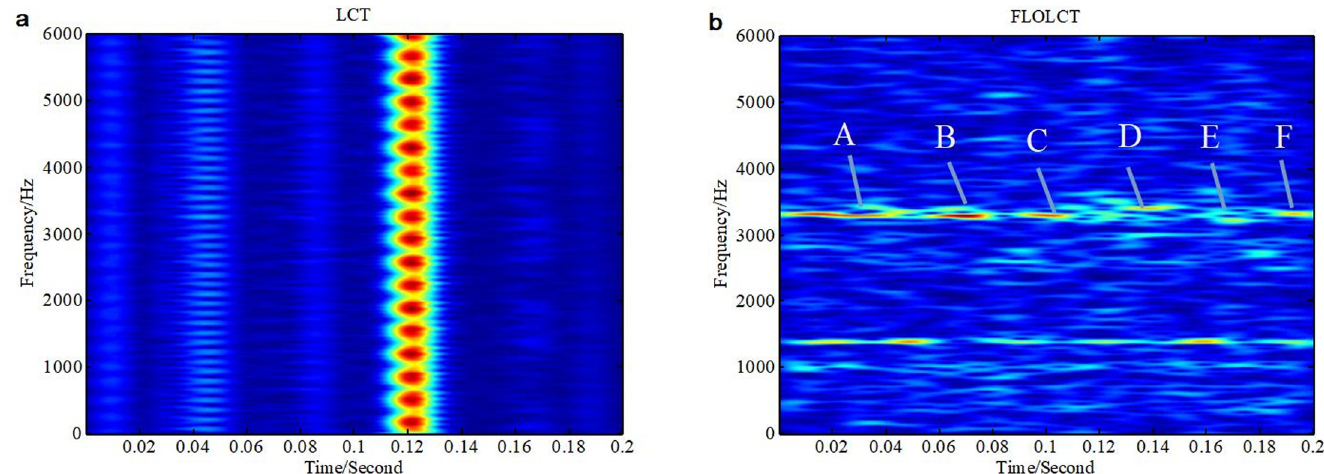
Fig 11. The time-frequency representations of the bearing ball fault in the position of DE data contaminated by α stable distribution noise ( MSNR = 18 dB , α = 0.8). (a. LCT time-frequency representation ( c = 5); b. FLOLCT time-frequency representation ( c = 5, p = 1.2)).